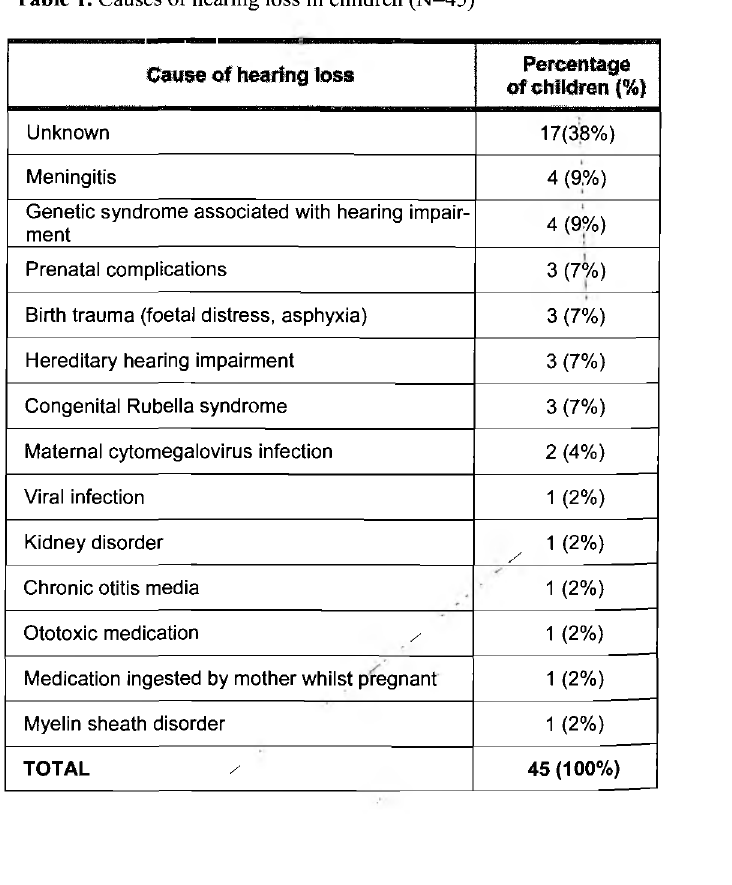
Table 1. Causes of hearing loss in children